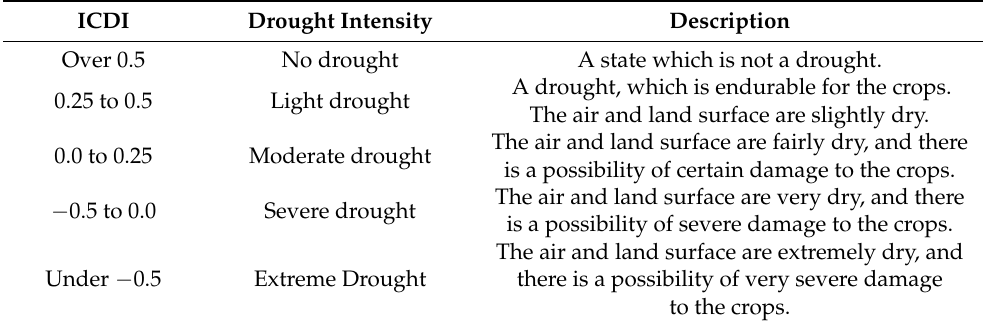
Table 5. Classification of Integrated Crop Drought Index (ICDI).